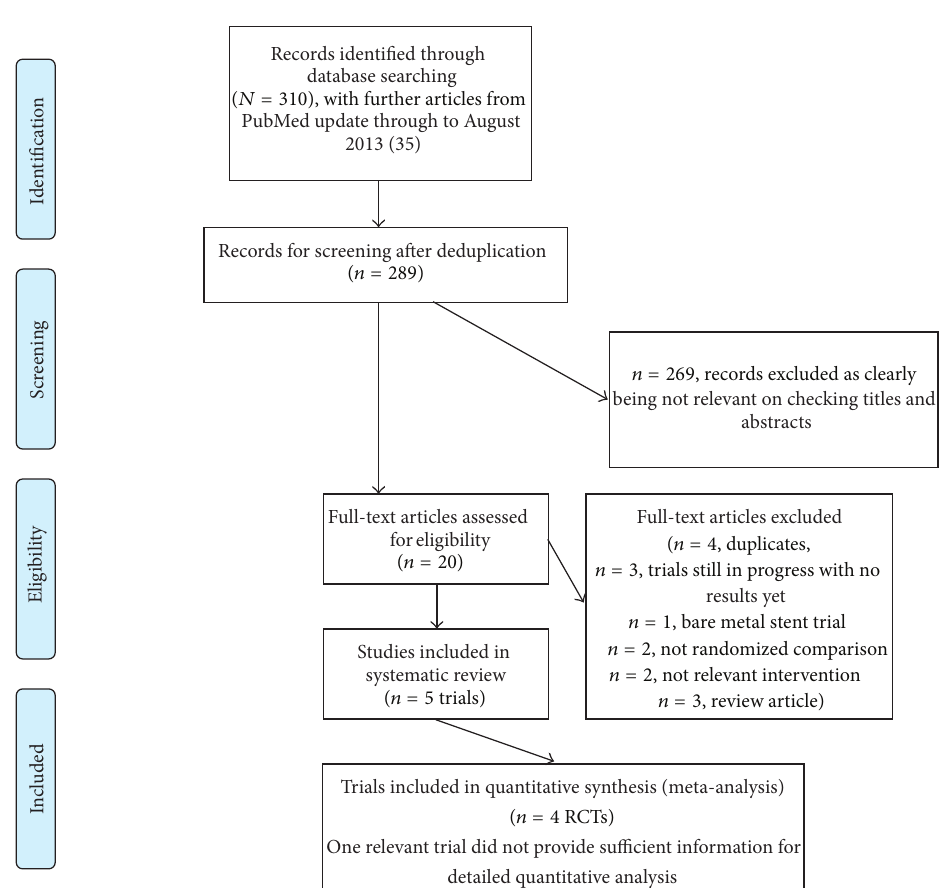
Figure 1: Flow diagram of study selection (from [15,